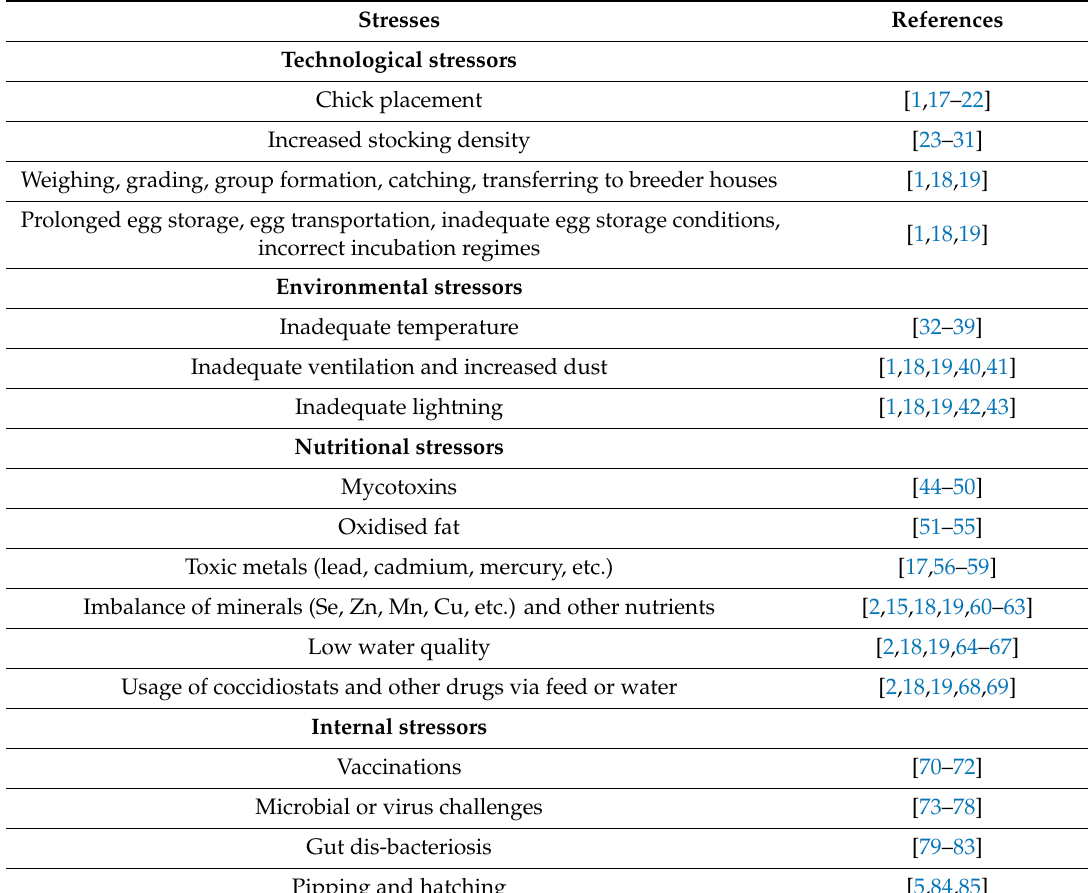
Table 1. Main stressors in poultry